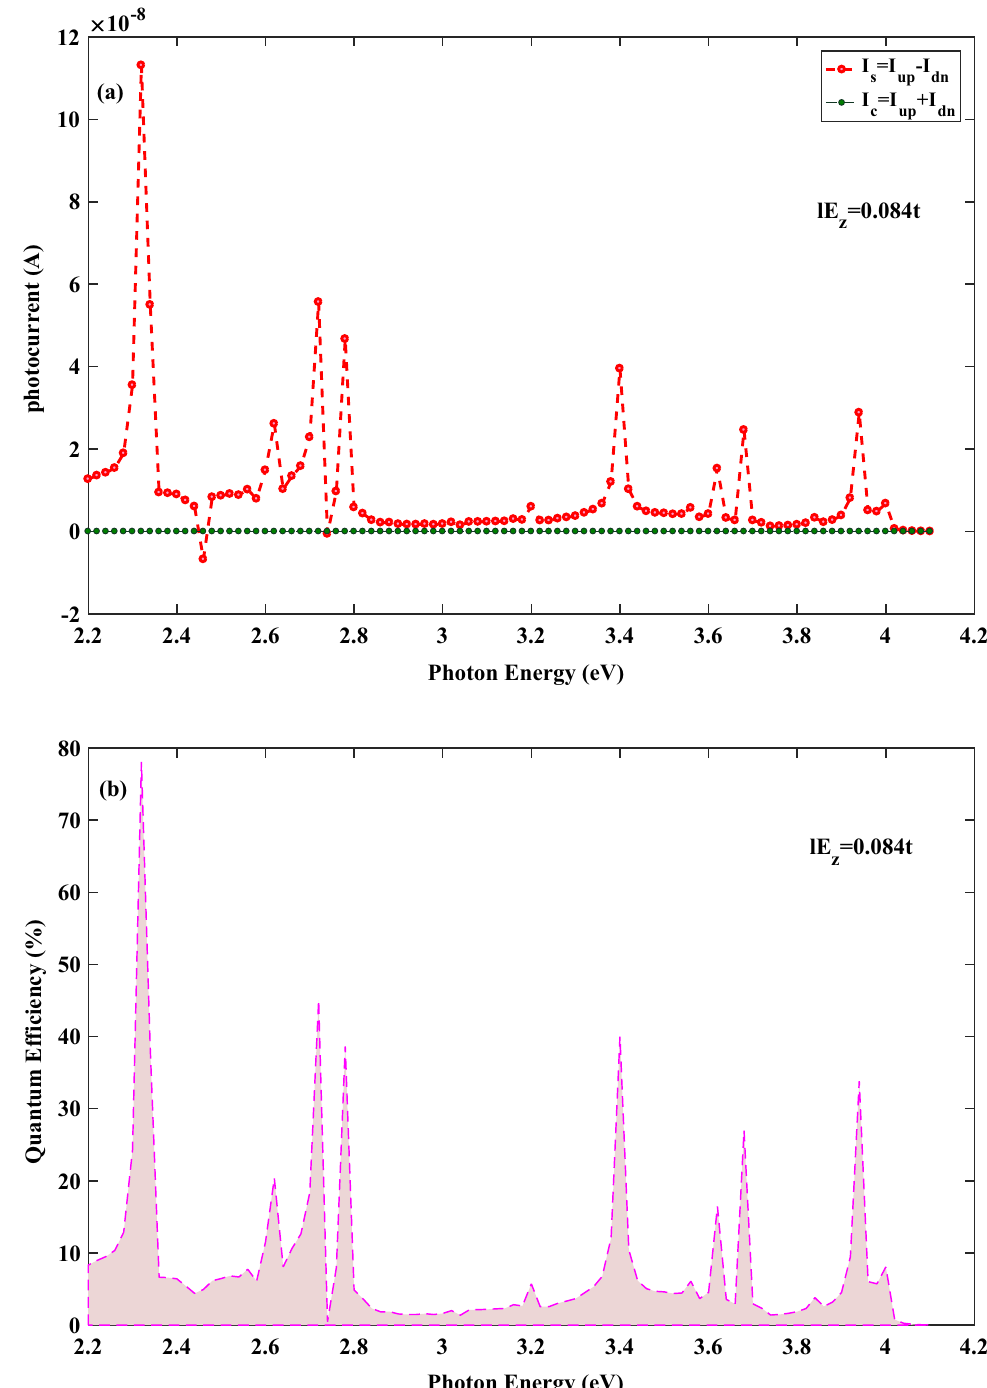
Figure 2. ( a ) Spin and charge photocurrent and ( b ) Quanmtum efficiency as a function of the photon energy for the spin-photovoltaic device based on 8 SZNR under the simultaneous effect of linear illumination with 0.084 t 100 kW elE z I w cm 2 and = =